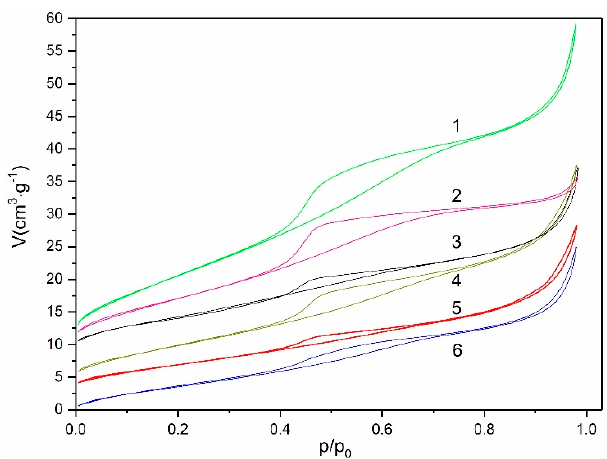
Figure 1. Adsorption–desorption isotherms of Ce x Zr 1 − x O 2 and Ni-Ce x Zr 1 − x op catalysts: 1—Ce 0.7 Zr 0.3 , 2—Ce 0.5 Zr 0.5 , 3—Ce 0.3 Zr 0.7 , 4—Ni-Ce 0.7 Zr 0.3 op, 5—Ni-Ce 0.5 Zr 0.5 op, and 6—Ni-Ce 0.3 Zr 0.7 op. Note: samples isotherms were shifted along the Y -axis for clarity to avoid superposition. Table 1. Textural characteristics of the Ce x Zr 1-x O 2 and Ni-containing catalysts.